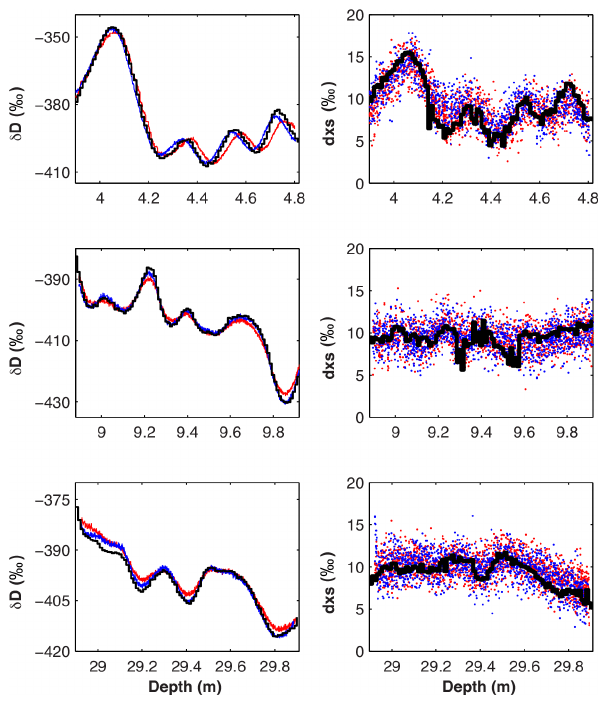
Figure 10. Replicate SPF ice measurements of δ D and dxs at depths of ∼ 4, 9, and 29m, corresponding to densities of 340, 386, and 562kg m − 3 , respectively. The red and blue data are from SPF sticks analyzed on the CRDS-CFA system, and the black data are 1cm discrete samples analyzed on a separate Picarro